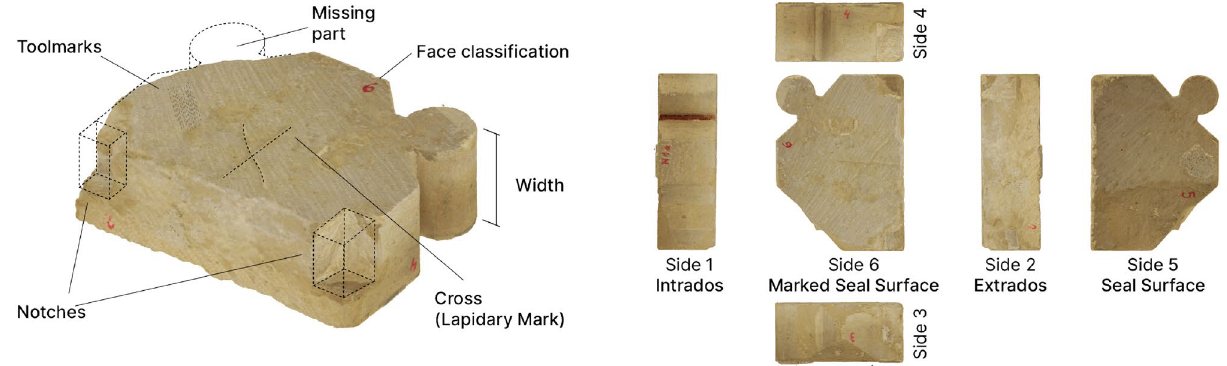
Figure 2. The components of the collapsed arch: the voussoirs, standardized and manufactured building elements.